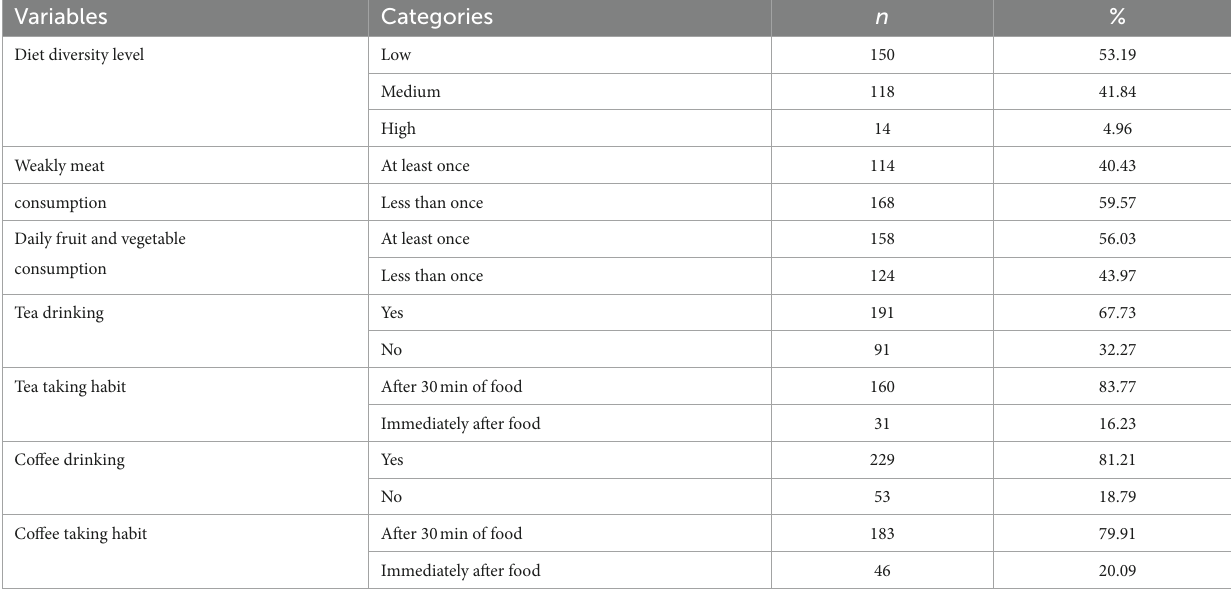
TABLE 3 Nutritional characteristics of postnatal women in Gondar town, Northwest Ethiopia, 2021 ( n =